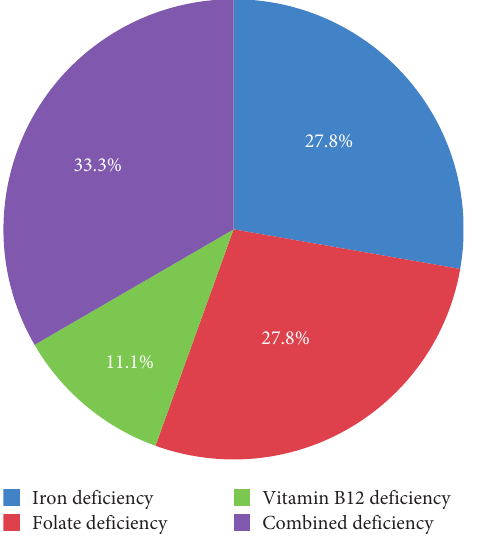
Figure 4: Proportion of nutritional deficiency anaemia, N �